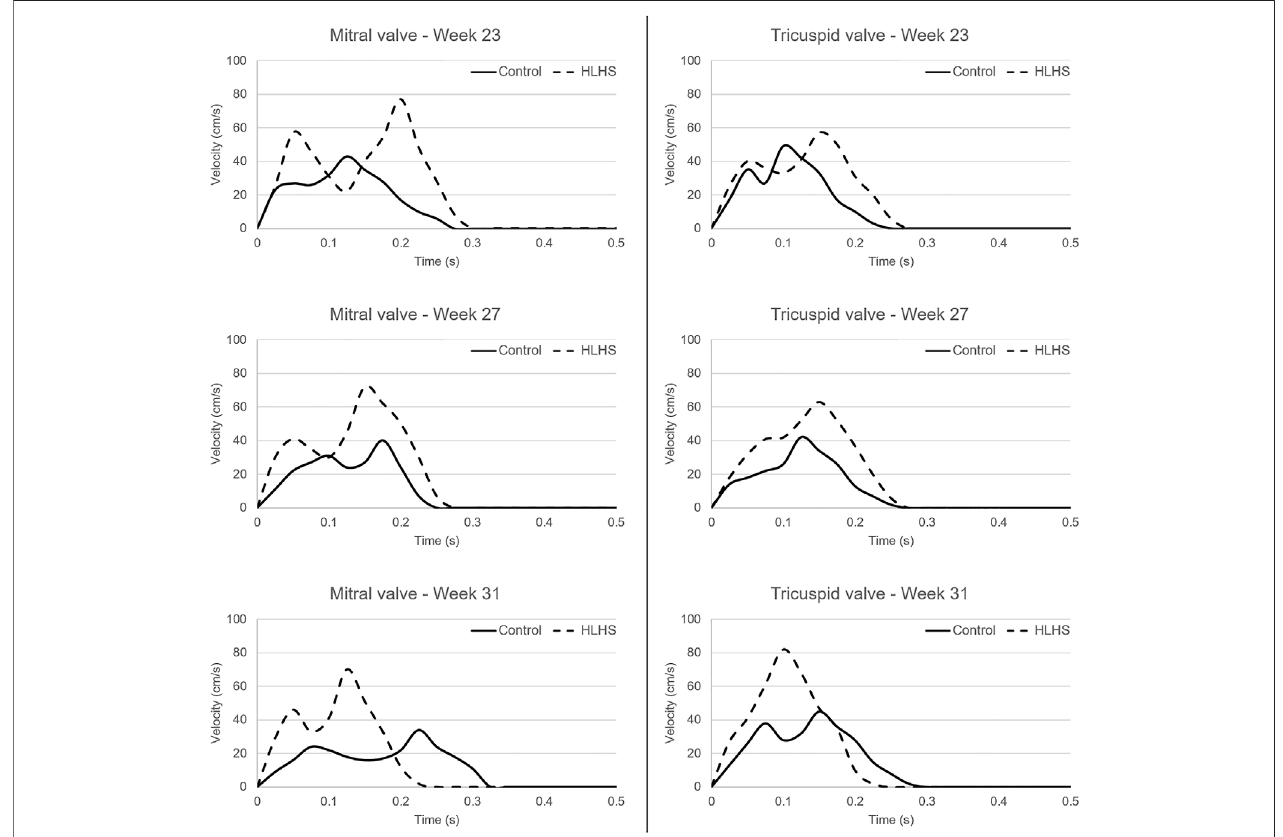
FIGURE 5 | Flow waveforms in the mitral and tricuspid valves of the control and HLHS hearts at gestational weeks 23, 27, and 31.